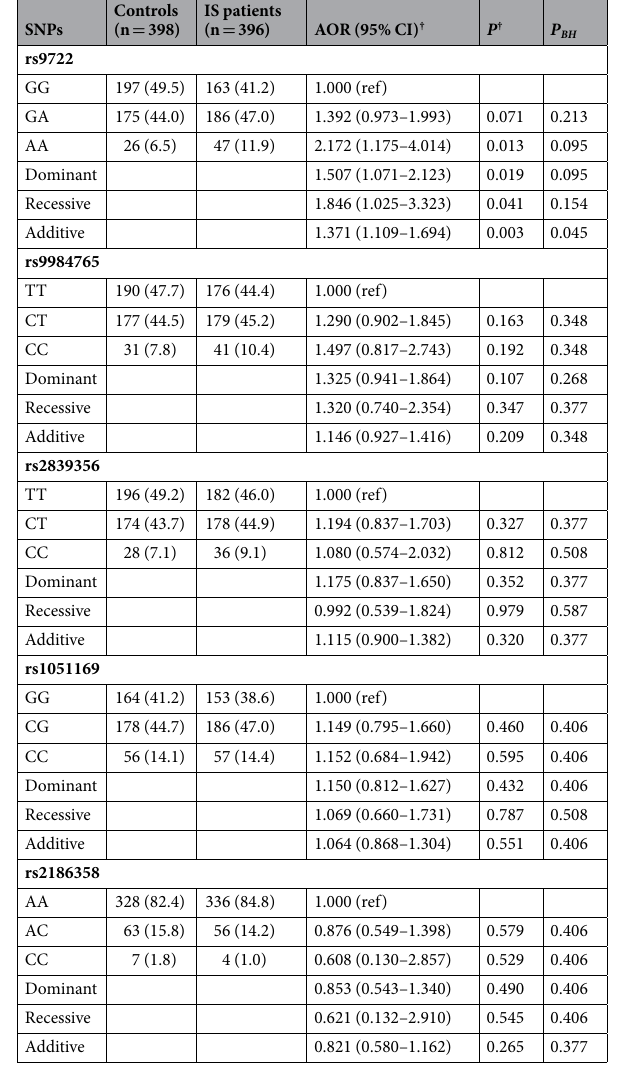
Table 2. Association between the S100B polymorphisms and risk of IS. IS, ischemic stroke; OR, odds ratio; 95% CI, 95% confidence interval. † Adjusted by age, gender, hypertension, diabetes mellitus, smoker, TCH, TG,